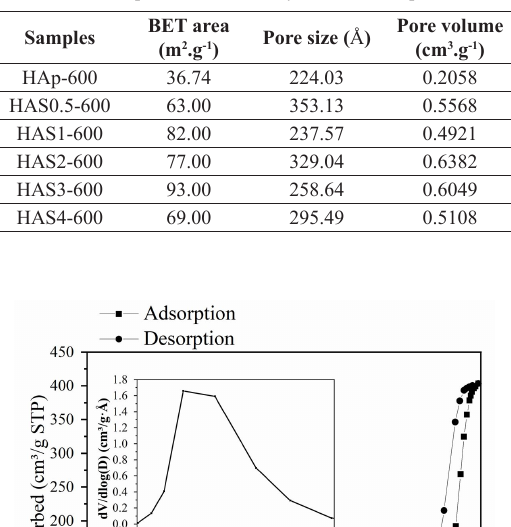
Figure 4. Adsorption/desorption isotherm of N sample. The pore size distribution by the BJH method is shown inserted in the figure.